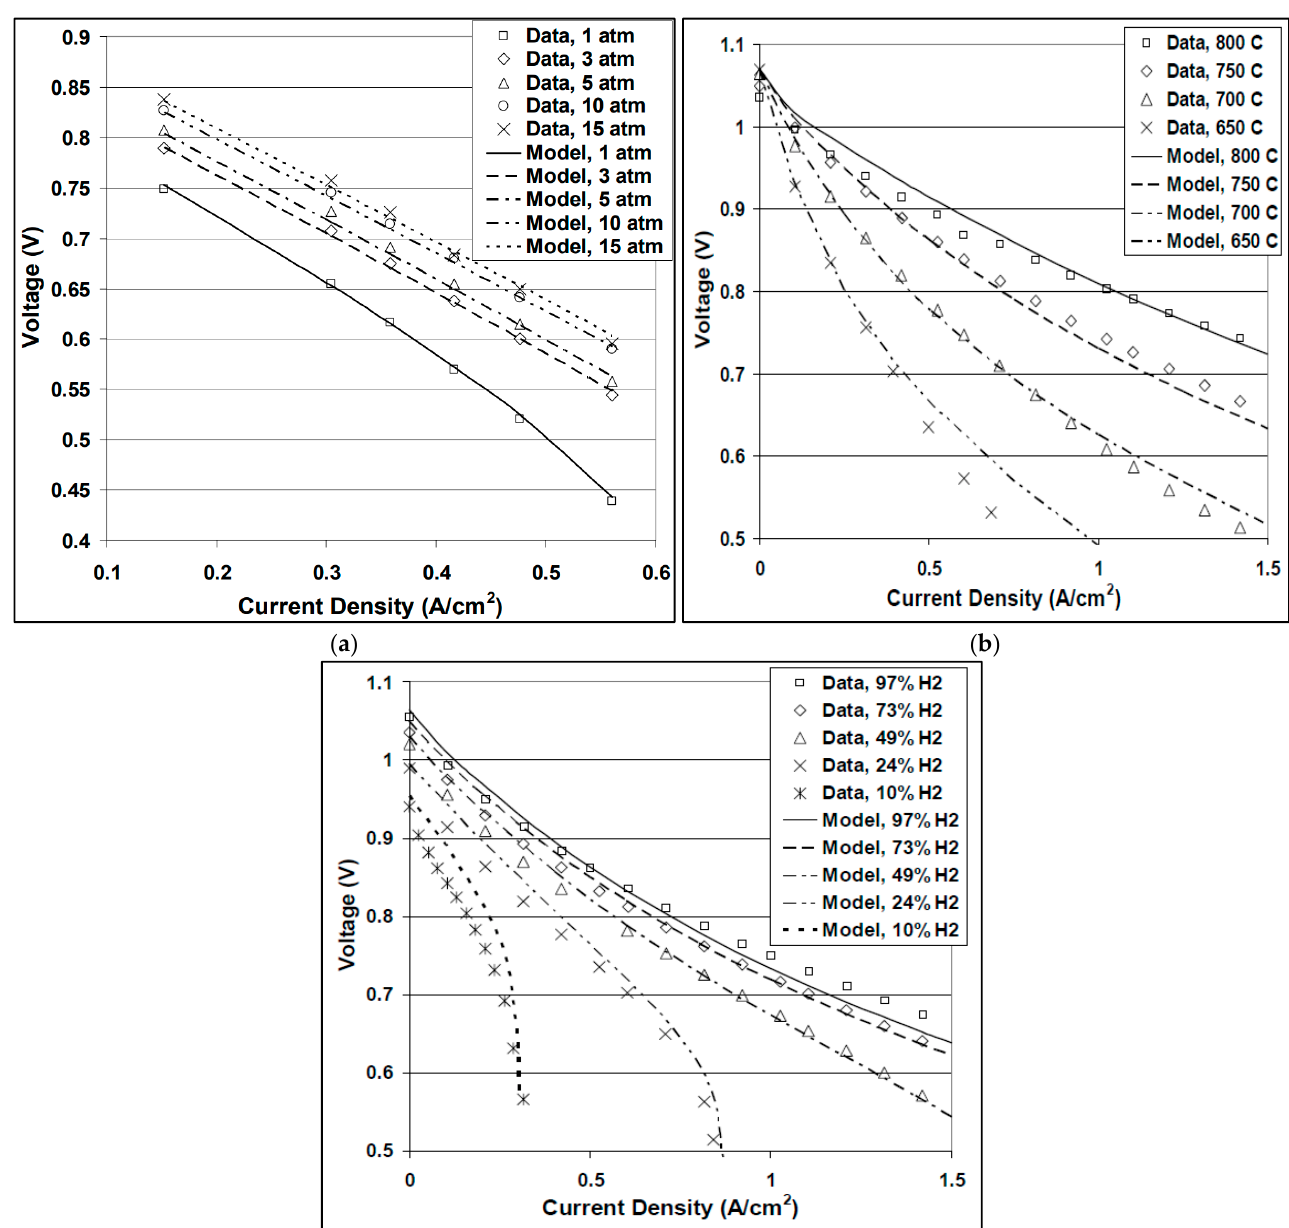
Figure 4. NPSS SOFC model results for ( a ) Siemens Westinghouse stack pressure data ( b ) PNNL temperature data and ( c ) PNNL anode feed composition data.